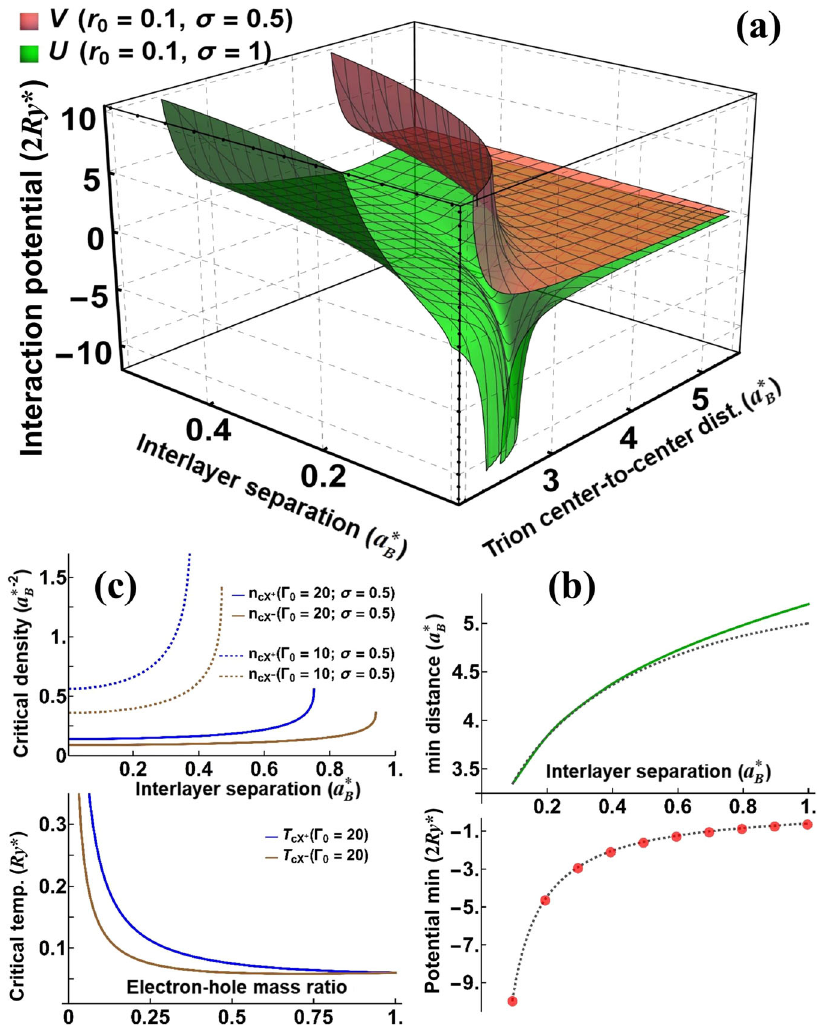
Fig. 3 Interaction potentials and crystallization. a The exact unlike-charge attractive and like-charge repulsive electrostatic interaction potentials U and V calculated for the pairs of charged interlayer excitons (CIEs) shown in Fig. 1 with electron-hole effective mass ratio σ = 1 and 0.5, respectively, separated by the center-of-mass-to-center-of-mass distance R in bilayers with the screening length parameter r 0 = 0.1 and interlayer separation d . b The approximate analytical (dashed black lines) and computed d -dependences (interlayer separation) of the position R min (green line) and value U min (red dots) of the minimum for the U -potential surface in ( a ). c Wigner crystallization phase transition parameters calculated for the many-particle charged interlayer exciton (CIE) system with the average potential-to-kinetic energy ratio Γ 0 = 10 and 20 (for comparison): critical densities n c X ± as functions of the interlayer separation d for the positive and negative CIEs with electron-hole effective mass ratio σ = 0.5, and critical temperatures T ð W Þ hole effective mass ratio σ ð W Þ The quantities n and T are shown on the top and bottom of c X ± c X ± Fig. 3c as functions of d and σ ( < 1), respectively, for moderate Γ 0 values 49 . As d increases so does 〈 V 〉 once the dipole repulsion becomes appreciable. With constant Γ 0 this leads to the 〈 K 〉 increase rise, accordingly. The latter is slightly lower for the and n c X ± negative CIE due to its smaller K because of the smaller mass than that of the positive CIE. Lowering σ generally lowers the CIE mass ð W Þ increases. These are the general thus decreasing its K whereby T c X ± trends featured in Fig. 3c.